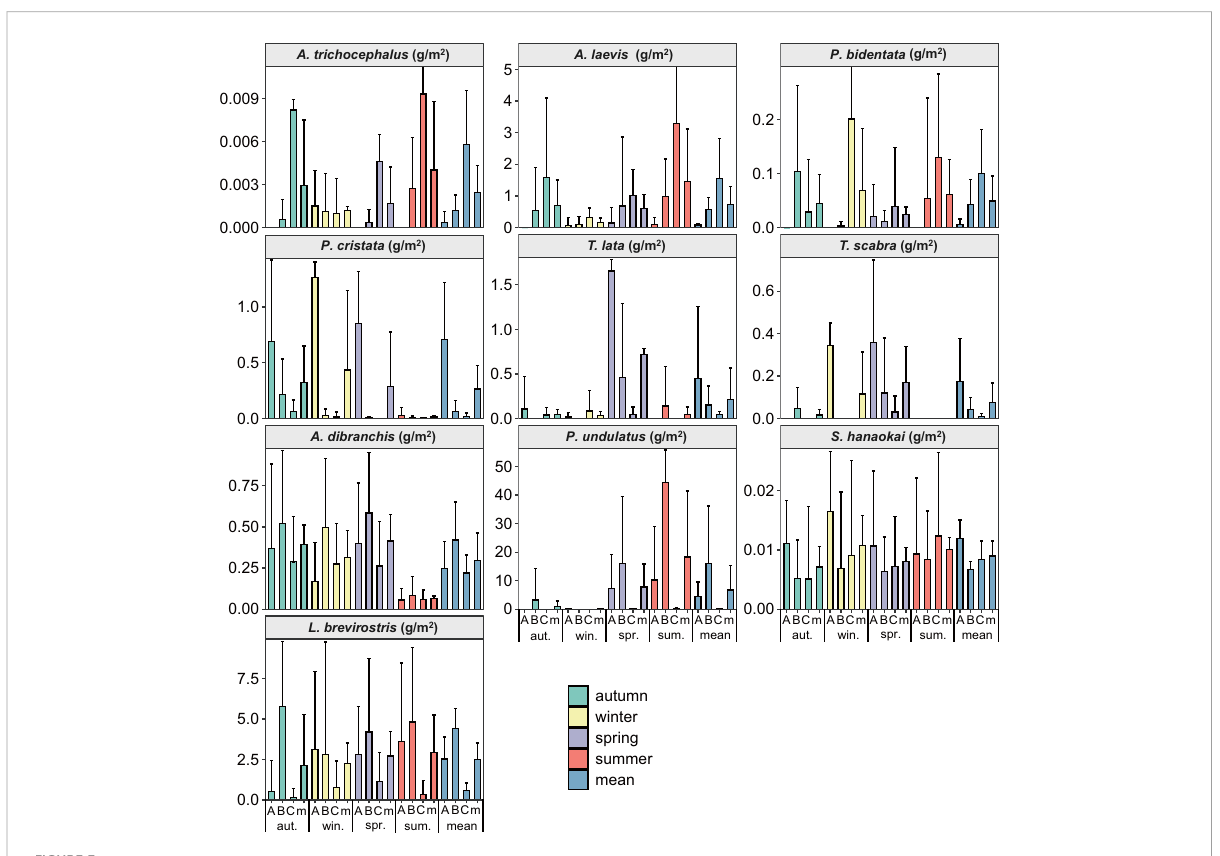
FIGURE 3 The biomass spatial and temporal distributions of ten species benthic macrofauna in subtidal zone near the Daya Bay Nuclear Power Plant. (A: represent the inner bay; B: represent the middle bay; C: represent the outside bay; m: represent the mean value).